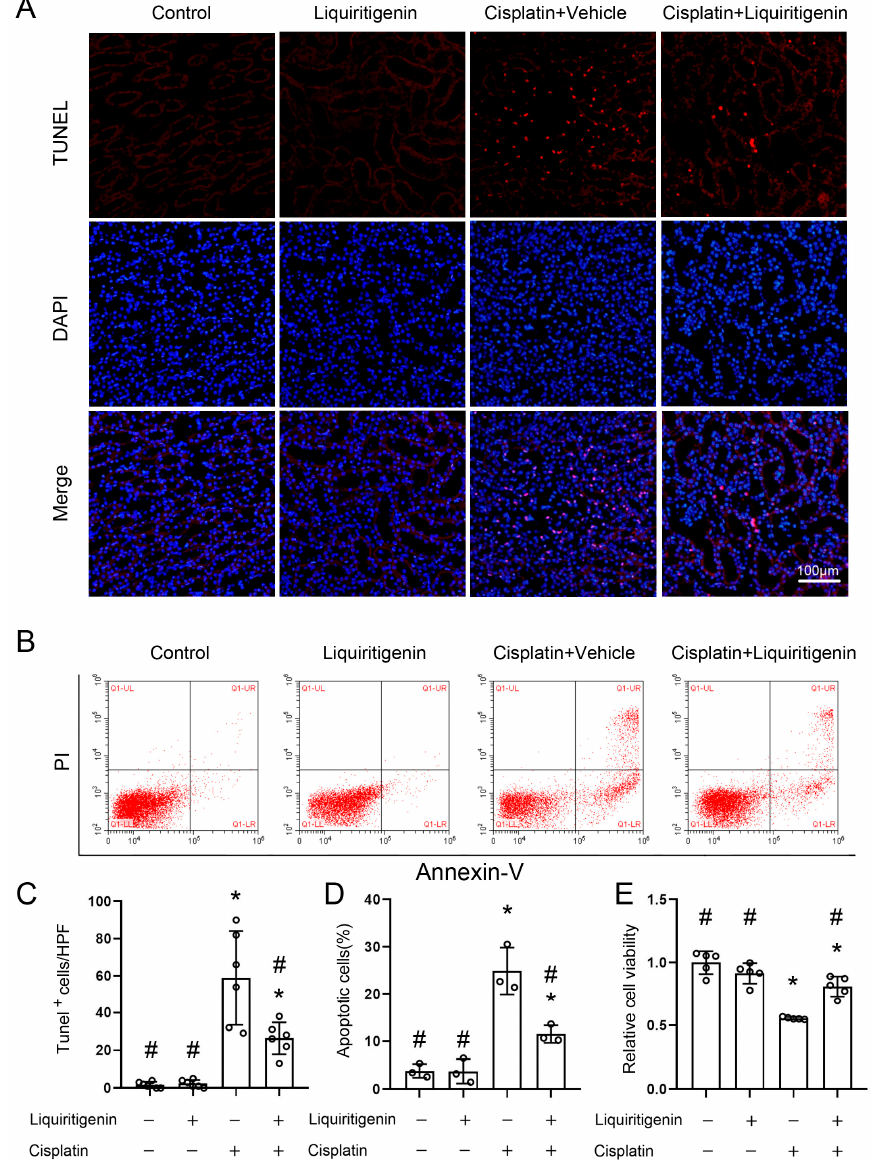
Figure 2. The effect of liquiritigenin on CP-induced apoptosis of renal tubule epithelial cells. ( A ) TdT-mediated dUTP nickend labeling (TUNEL) assays were performed to assess renal cell death. Nuclei were revealed using 4 ′ ,6-diamidino-2-phenylindole staining. ( B ) Representative flow charts showed that cell apoptosis was determined by flow cytometric analysis in renal tubule epithelial cells with different treatments. Cells stained with fluorescein isothiocyanate (FITC)-conjugated AnnexinV and propidiumiodide (PI). ( C ) Quantitative assessment of the TUNEL + cells (numbers per high-power field) in mice kidneys. * p < 0.05 vs. vehicle-control group, # p < 0.05 vs. CP treatment group ( n = 6 mice/group). ( D ) Quantification of the percentage of apoptotic cells. * p < 0.05 vs. vehicle-control group, # p < 0.05